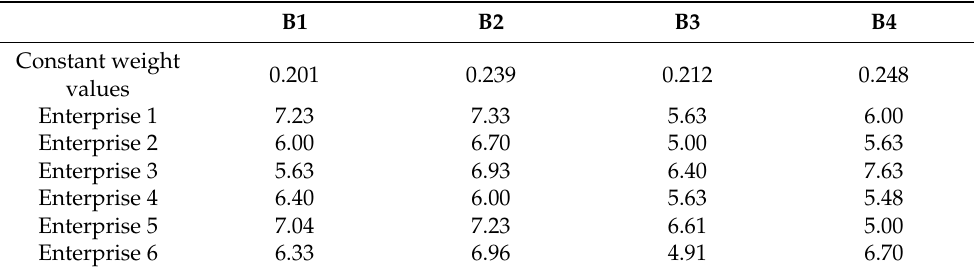
Table 6. Evaluation values of the secondary indicators of energy conservation and carbon reduction (B) of the six evaluated enterprises after defuzzification.